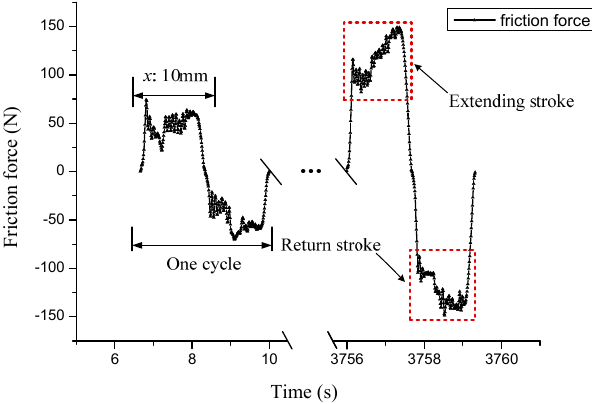
Figure 3. Friction force curve in the case of the right cross, and the crossing angle is 28°. The extending stroke and return stroke are marked by the dashed lines.